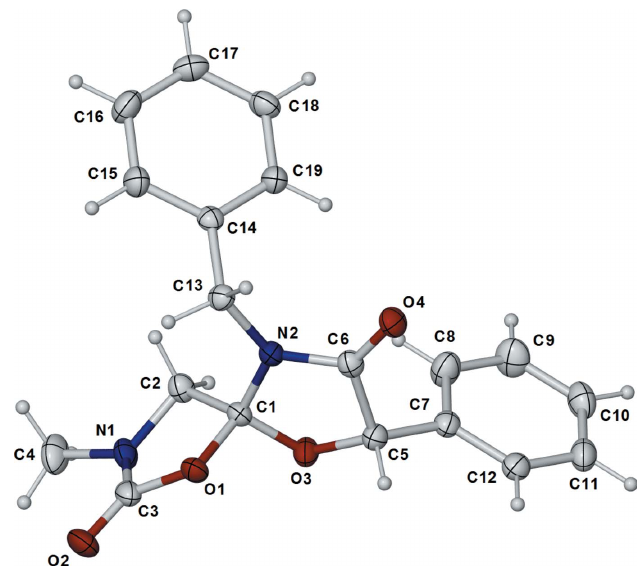
Figure 2 Molecular structure of ( R , R / S , S )-9-benzyl-3-methyl-7-phenyl-1,6-dioxa- 3,9- diazaspiro[4,4]nonane-2,8-dione with non-hydrogen atoms repre- sented by 50% displacement ellipsoids and hydrogen atoms as spheres of arbitrary size. The 5- S ,7- S diastereomer is